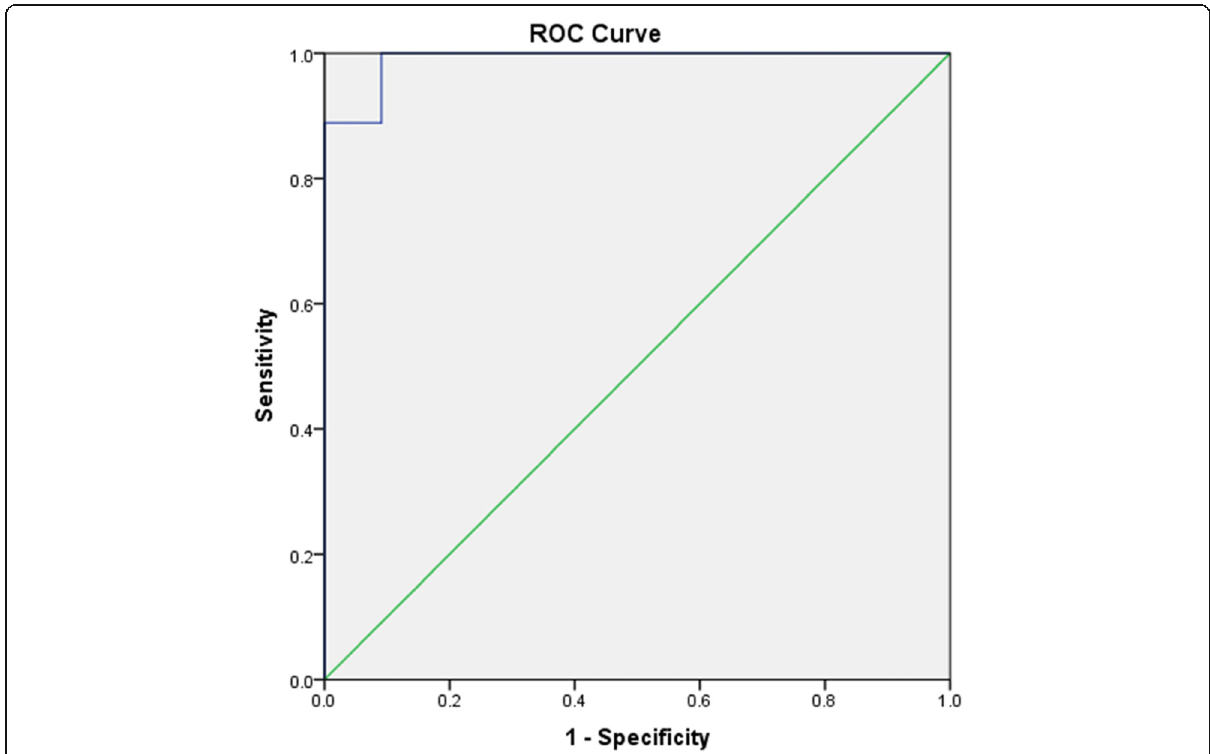
Fig. 6 ROC curve for FASTT as a predictor of birth weight > 2500 g (SGA)